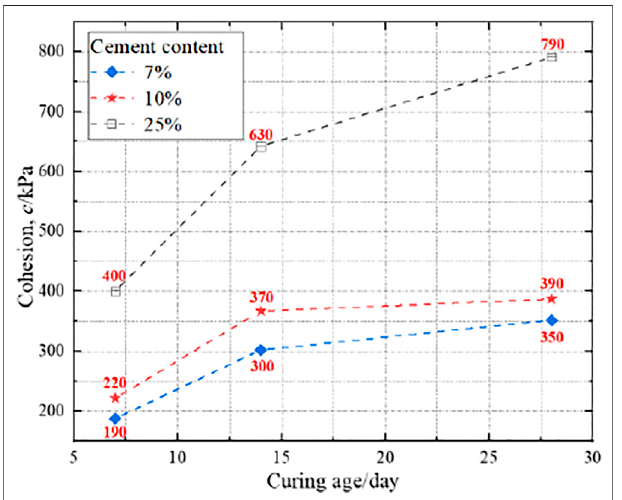
FIGURE 4 | Relationship curve between cohesion and curing age. FIGURE 5 | Relationship curve between internal friction angle and